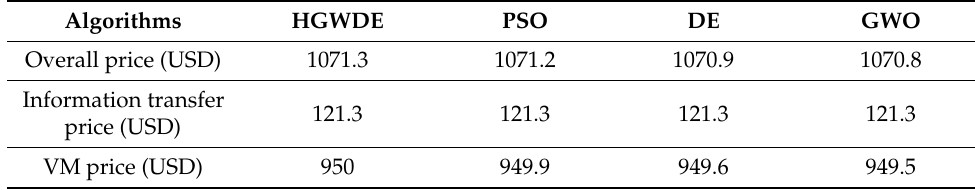
Table 5. Overview of price for each